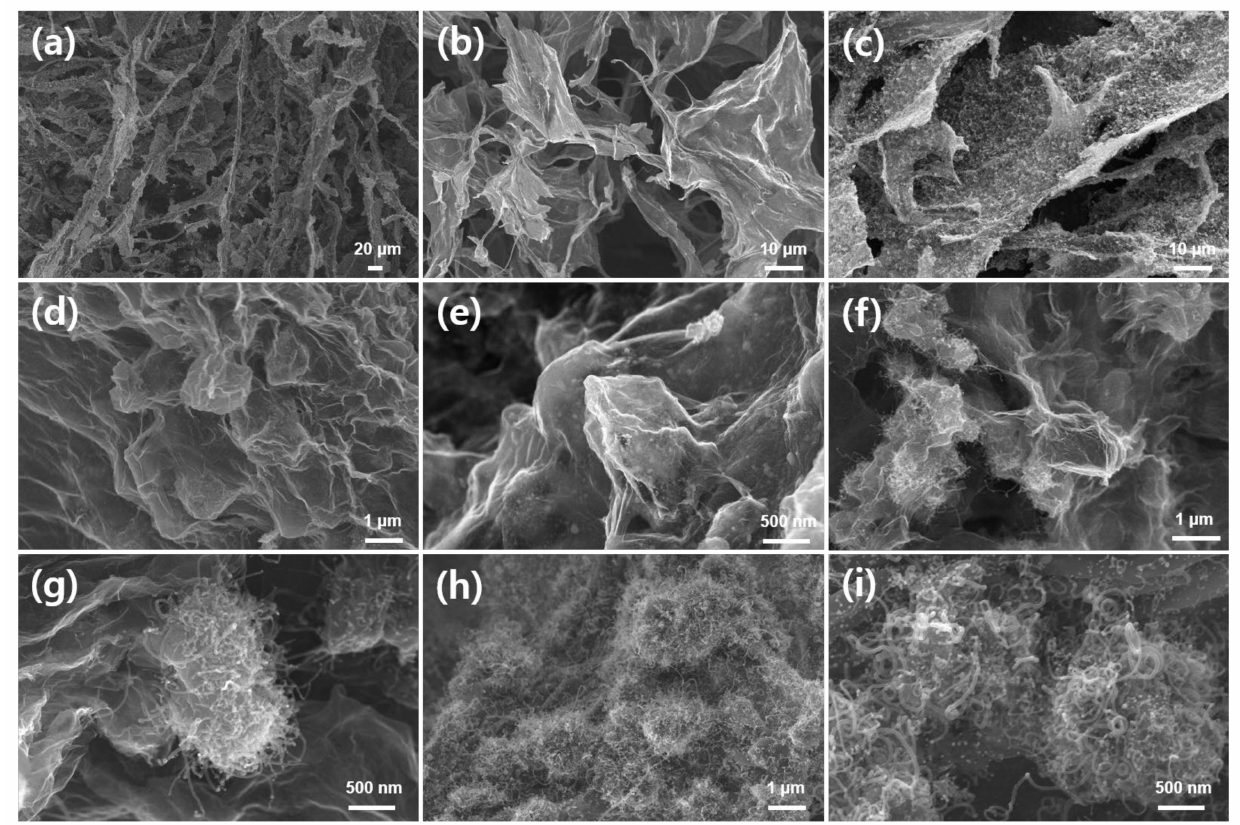
Figure 2. SEM images of ( a , b ) carbon sponge (CS), ( c , d ) CS@Co, ( e , f ) CS@Co@CNTs-external, ( g – i )